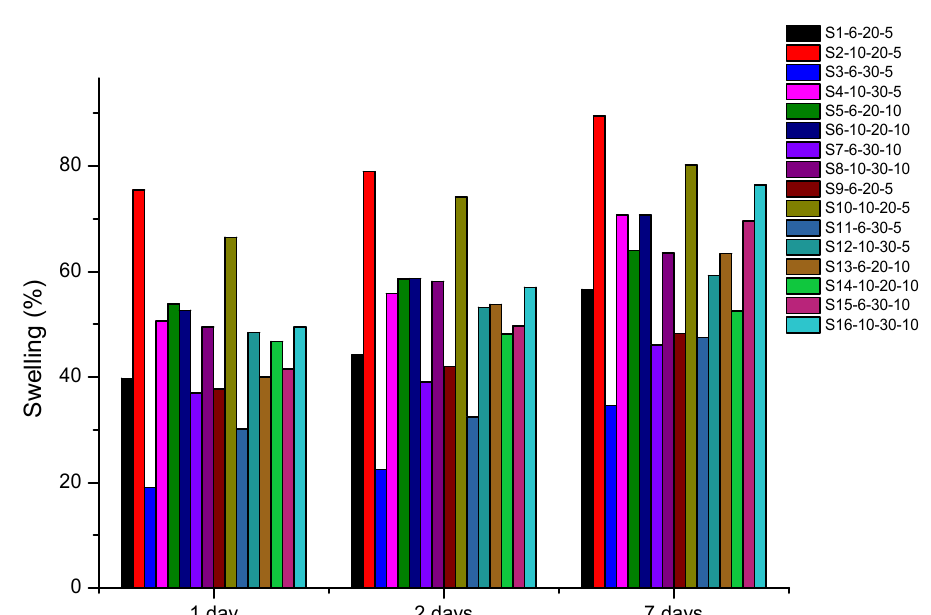
Figure 6. Absorption profile in phosphate-buffered saline (PBS) from all spheres of experimental planning.